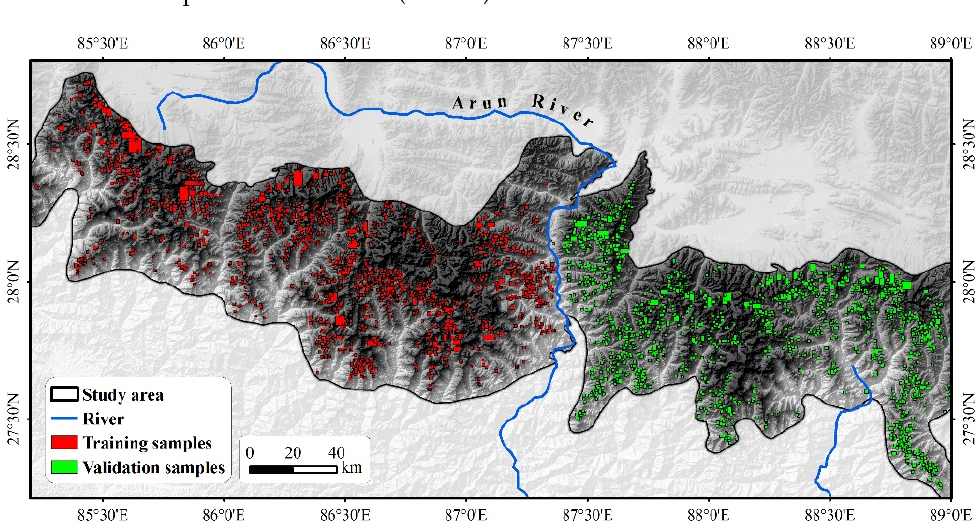
Figure 6. Distribution of training and validation samples used for classification. Table 3. Number of glacial and nonglacial lakes in the study area used for training and validation.